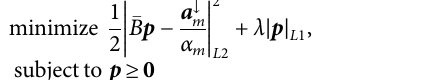
FIGURE 5 | Analysis of inter network mappings. Sets of two networks are trained on robots with different number of joints. A projection matrix P that re fl ects the network similarity is calculated to compute ^ a from the source network neuron activation b with minimal difference to a .